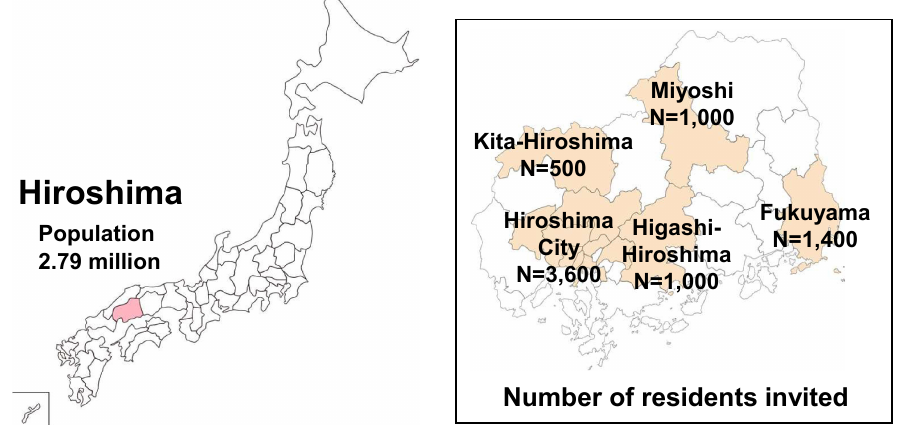
Fig. 1 Study setting in Hiroshima prefecture and number of residents invited to participate Of the 23 cities in Hiroshima prefecture, fi ve cities were selected for the study. The number of participants invited in each city was adjusted to the total population in the city.